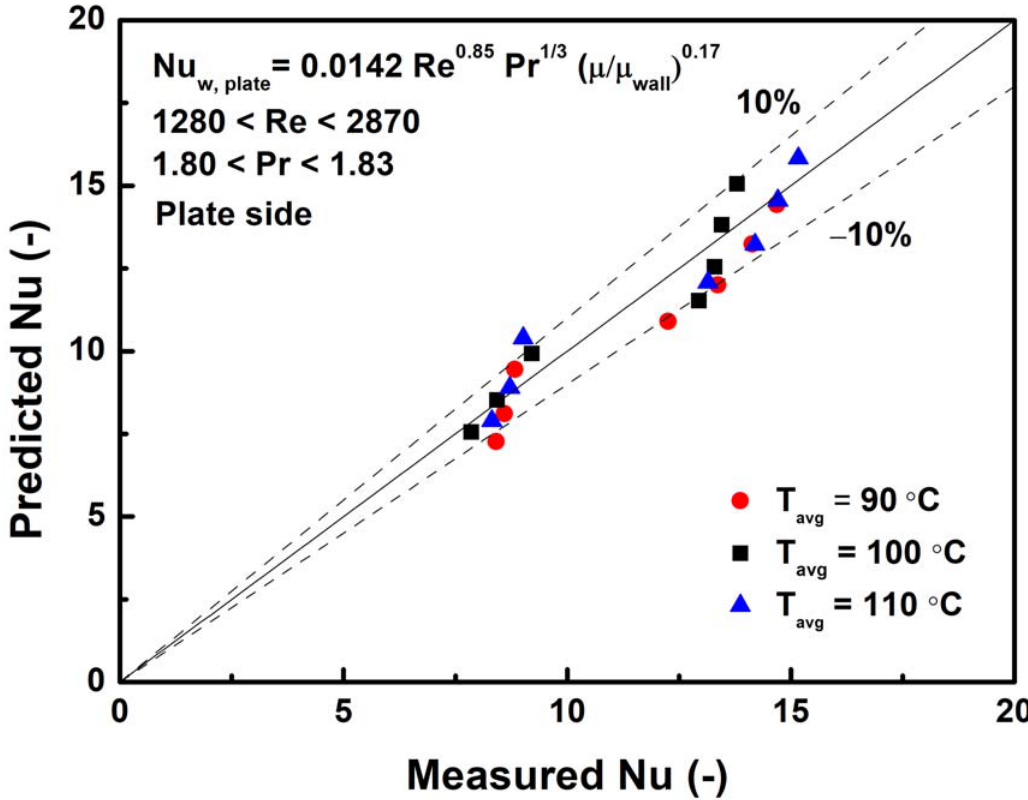
Figure 6. Comparison of the predicted with measured Nu on the plate side of the PSHE.